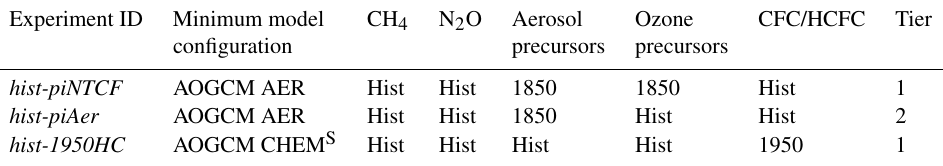
Table 1. List of historical coupled-ocean experiments. Experiments cover the period between 1850 and 2014, except hist-1950HC , which starts in 1950. The “AER” suffix means models should at least calculate tropospheric aerosols driven by emission fluxes. The “CHEM S ” suffix means at least stratospheric chemistry is required. Models should always be run with the maximum complexity available. The species columns refer to the specifications for concentrations (CH 4 , N 2 O and CFC/HCFC) or emissions (aerosol and ozone precursors). “Hist” means the concentrations or emissions should evolve as for the CMIP6 historical simulation; a year means the concentrations or emissions should be fixed to that year. Three ensemble members are requested for each